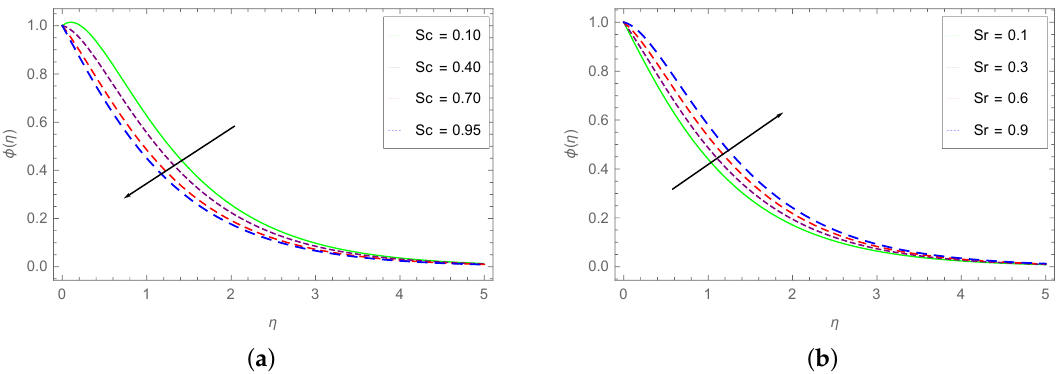
Figure 9. ( a ) φ ( η ) dependence on Sc and ( b ) dependence of φ ( η ) on Sr .